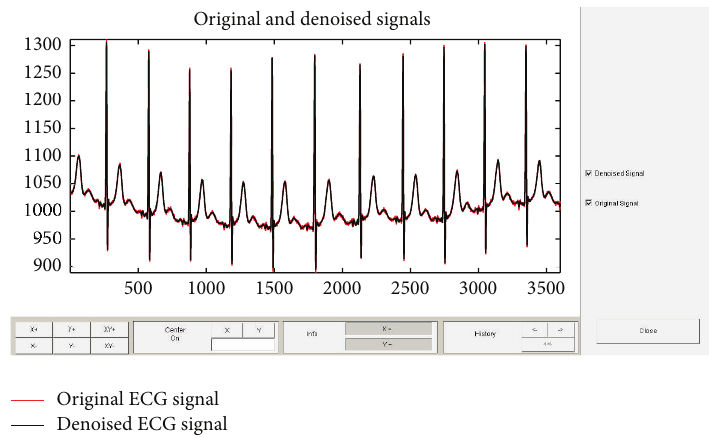
Figure 3: Original and denoised signals for ECG record no 103m using Biorthogonal